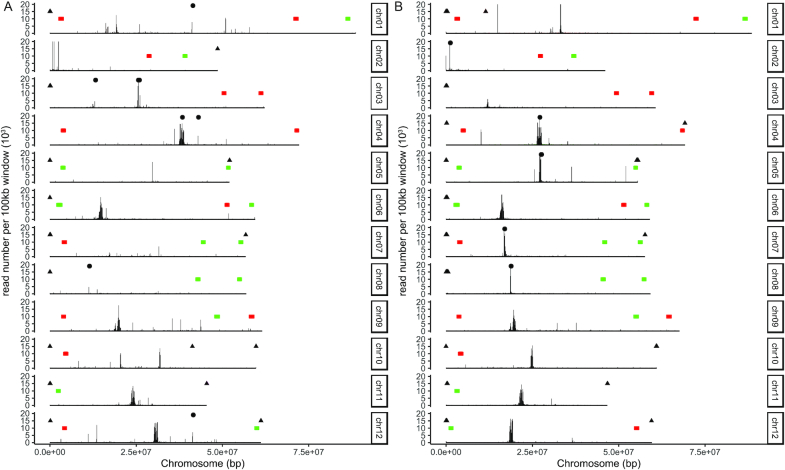
Distribution of subtelomeric repeat sequences, centromeric repeat sequences, CENH3 ChIP-seq alignments, and oligonucleotide fluorescent in situ hybridization (oligo-FISH) probes. (A) Distribution of features on DM v4.04 assembly. (B) Distribution of features on DM v6.1 assembly. Red and green rectangles represent the positions of the 2 “barcode” oligo-FISH probes [42]. For CENH3 ChIP-seq reads, chromosomes were divided into 100-kb windows and CENH3 read number in each window was calculated and plotted [45]. Circles represent centromeric repeats [45]. Triangles represent subtelomeric repeats [55].